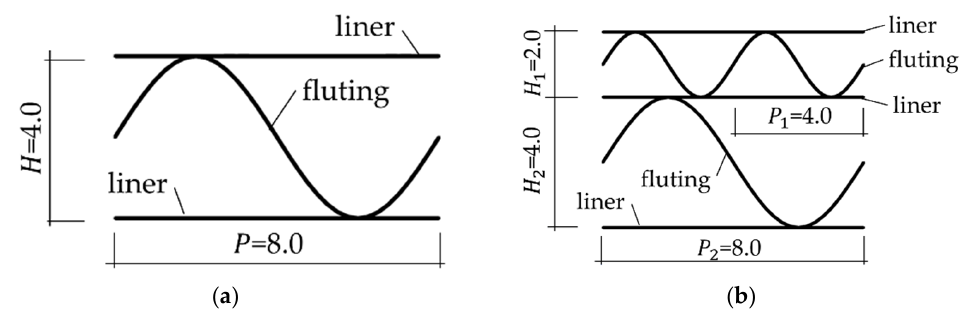
Figure 4. Geometry of the sample: ( a ) single layer; ( b ) double layer.